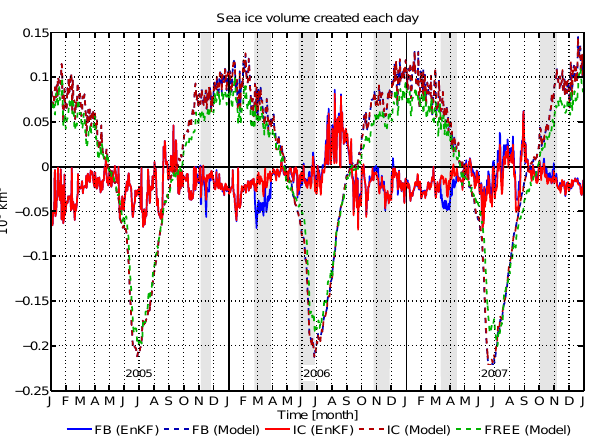
Fig. 9. Times series over 2005–2007 sea-ice volume produced each day in the Arctic by the model (dashed line) and by the EnKF (solid line) for FB (blue), IC (red) and FREE (green). Gray areas indicate the periods when ice freeboard data are available.